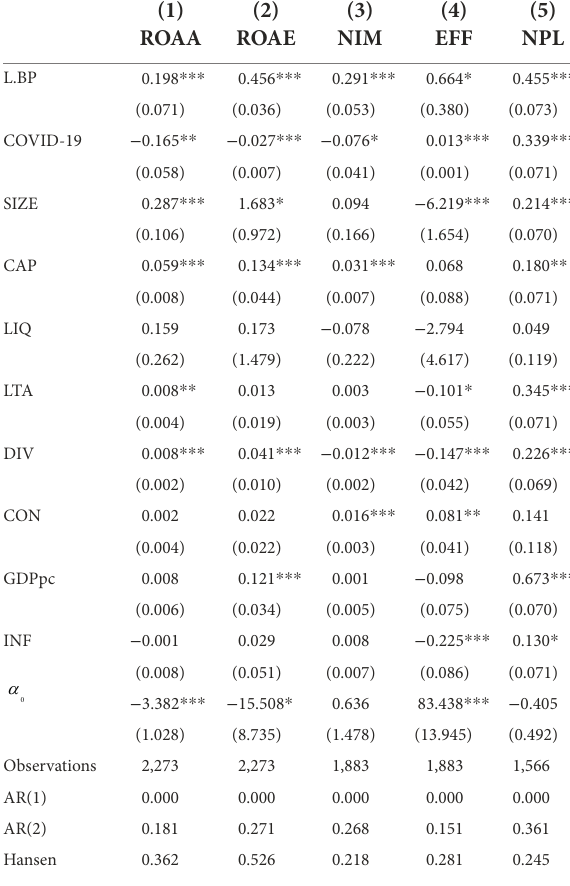
This table expresses the impact of the COVID-19 epidemic on bank performance by using the System GMM. The sample comprises 1,575 banks in 85 countries from 2020 Q1 to 2021 Q4. Our dependent variable is bank performance measured as ROA and ROE. COVID-19 is our primary explanatory variable of interest, measured as the total number of COVID-19 confirmed cases per million in the country. Robust standard errors are reported in